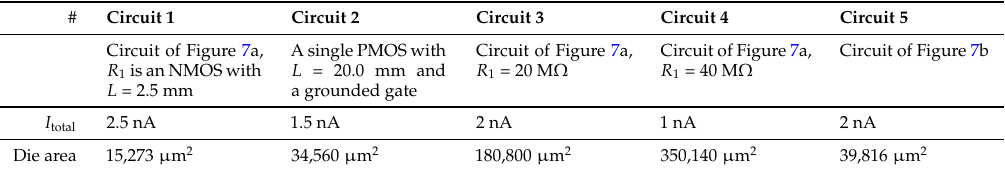
Circuit of Figure 7b